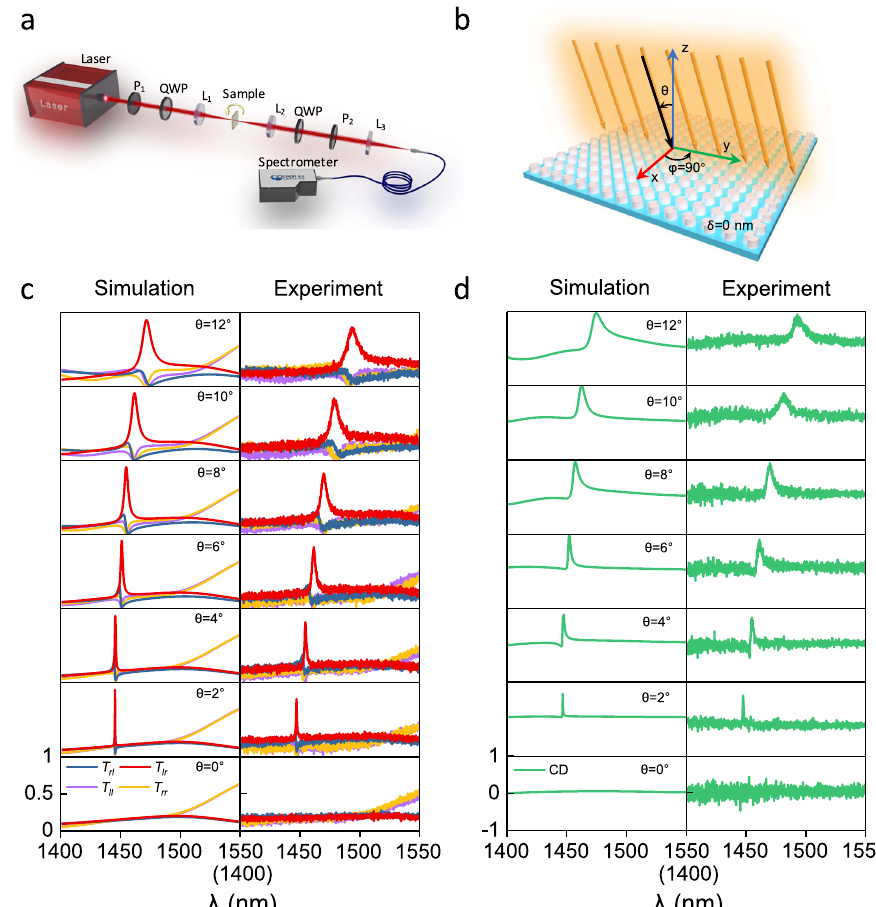
Fig. 3 Experimental veri fi cation of the extrinsic planar chiral q-BIC with illumination symmetry breaking. a Experimental setup for the Jones matrix spectra measurement under the circular polarization basis. P 1 and P 2 represent the polarizers, QWP is the quarter-wave plate, L 1 , L 2 , and L 3 are lenses. b Schematic of the metasurface with δ = 0 supporting chiral q-BICs through different incident angles along the φ = 90°direction. c Simulated and measured transmission Jones matrix spectra ( T lr , T rl , T rr and T ll ) for different incident angles ( θ = 0°, 2°, 4°, 6°, 8°, 10°, 12°) along the φ = 90° direction. d Simulated and measured CD spectra for different incident angles extracted from the Jones matrix spectra in ( c